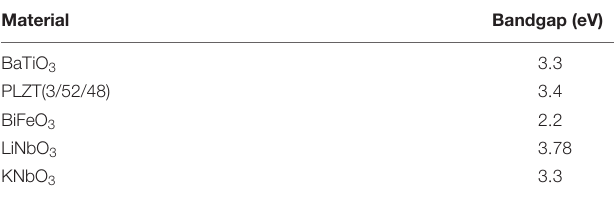
TABLE 1 | Bandgap values of ordinary FE oxides.